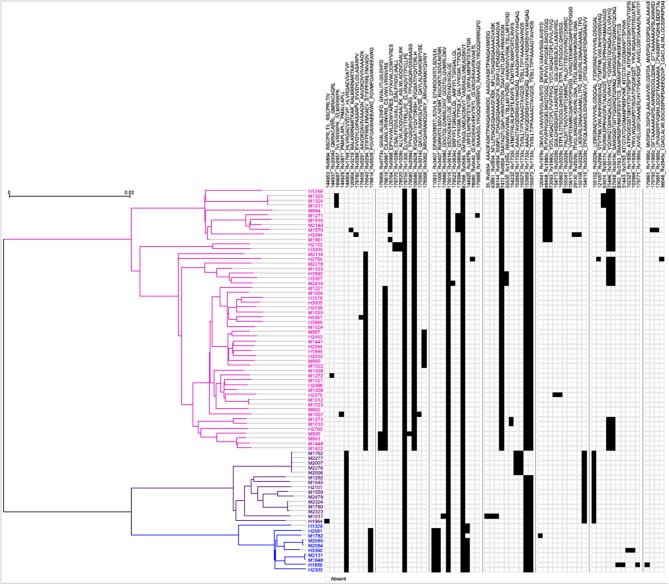
Schematic representation of the phylogenetic relationship of mTCEs of all 79 Mtb strains. Maximum Likelihood tree shows the phylogenetic relationship of the 79 strains studied, based on SNP data. The phylogeny shows two major clades, one consisting of 54 EAI lineage strains (pink), and another one consisting of two clusters, including 10 Beijing/BEI (blue) and 15 CAS (purple) lineage strains, following the naming convention in Comas et al. (13). Each of the columns represents one of the 64 mutated T-cell epitopes. The presence of a mutation in a particular strain is represented by a black square.